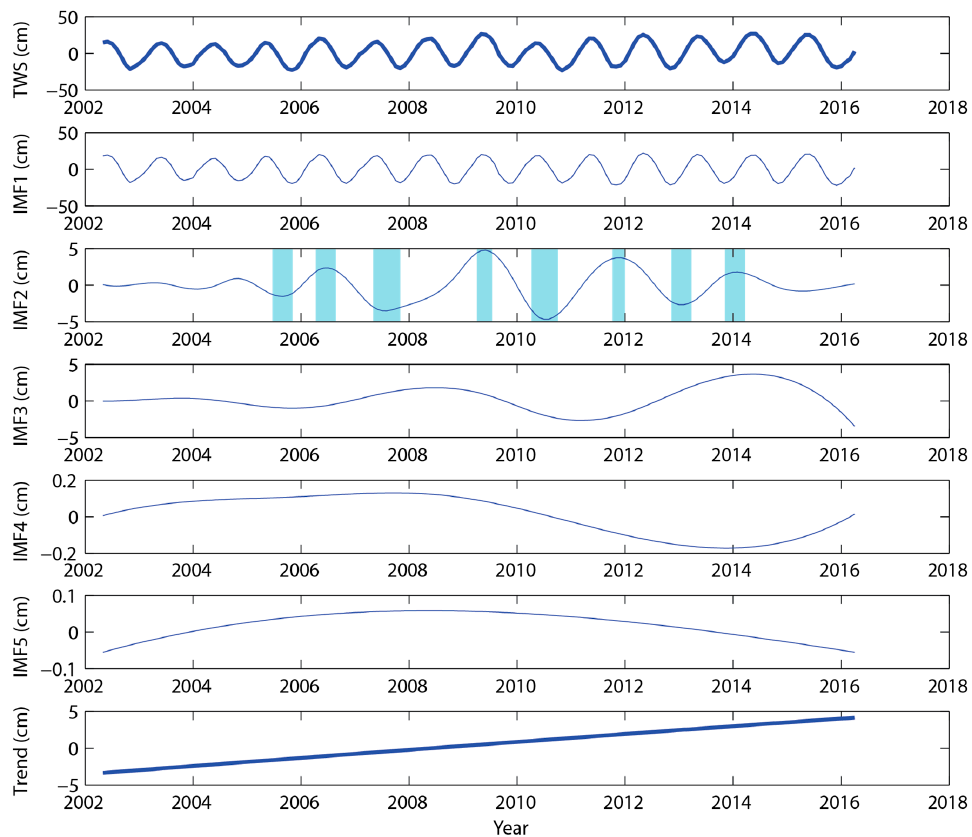
Figure 2. Empirical mode decomposition (EMD) analysis of Amazon River basin TWSA. Top panel shows the raw data and bottom panel shows the EMD trend. All 5 IMFs are shown in the middle panels. In this case, IMF2 reveals all major TWSA extremes occurred at the basin during the study period.